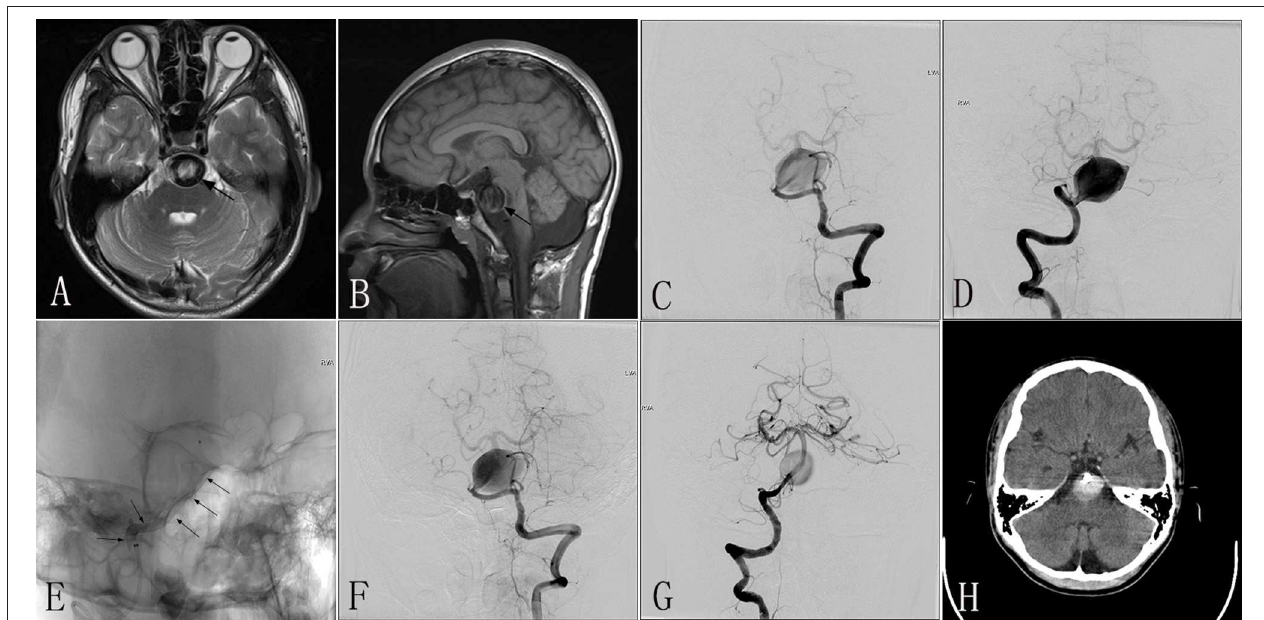
FIGURE 4 | Images from a 10- to 12-year-old patient with a giant dissecting aneurysm located in the basilar artery (case 4). (A,B) Preoperative MRI showing a basilar giant dissecting aneurysm with compression of the brainstem (black arrow). (C,D) Preoperative anteroposterior angiograms of the LVA (C) and RVA (D) confirming a giant dissecting aneurysm located in the basilar artery. (E) Intraprocedural unsubtracted view showing successful insertion of the PED (3.5 × 35mm) (black arrow). (F,G) Immediately postoperative anteroposterior angiograms of the LVA (F) and RVA (G) demonstrating excellent reconstruction of the basilar artery and evident contrast stasis in the lumen of the aneurysm. (H) CT performed 1 day after the procedure confirming no indications of SAH. LVA, left vertebral artery; RVA, right vertebral artery; PED, pipeline embolization device; SAH, subarachnoid hematoma.